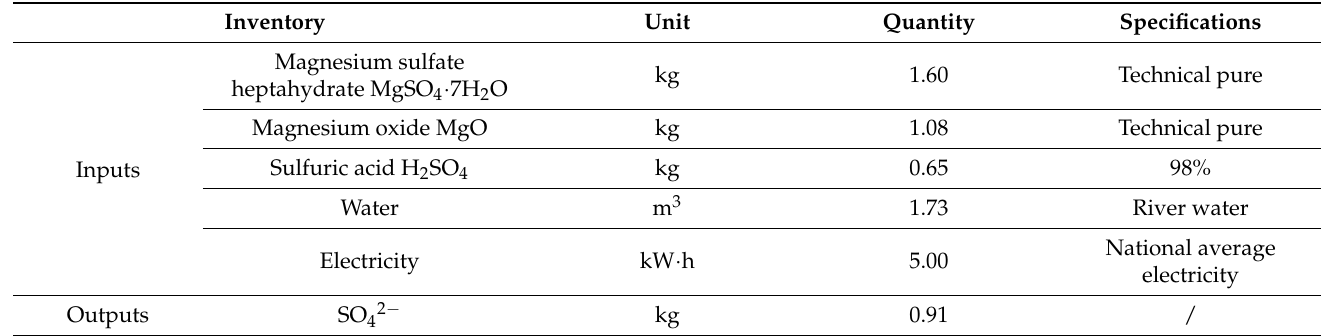
Table 2. Life cycle inventory data of the magnesium salt leaching process.